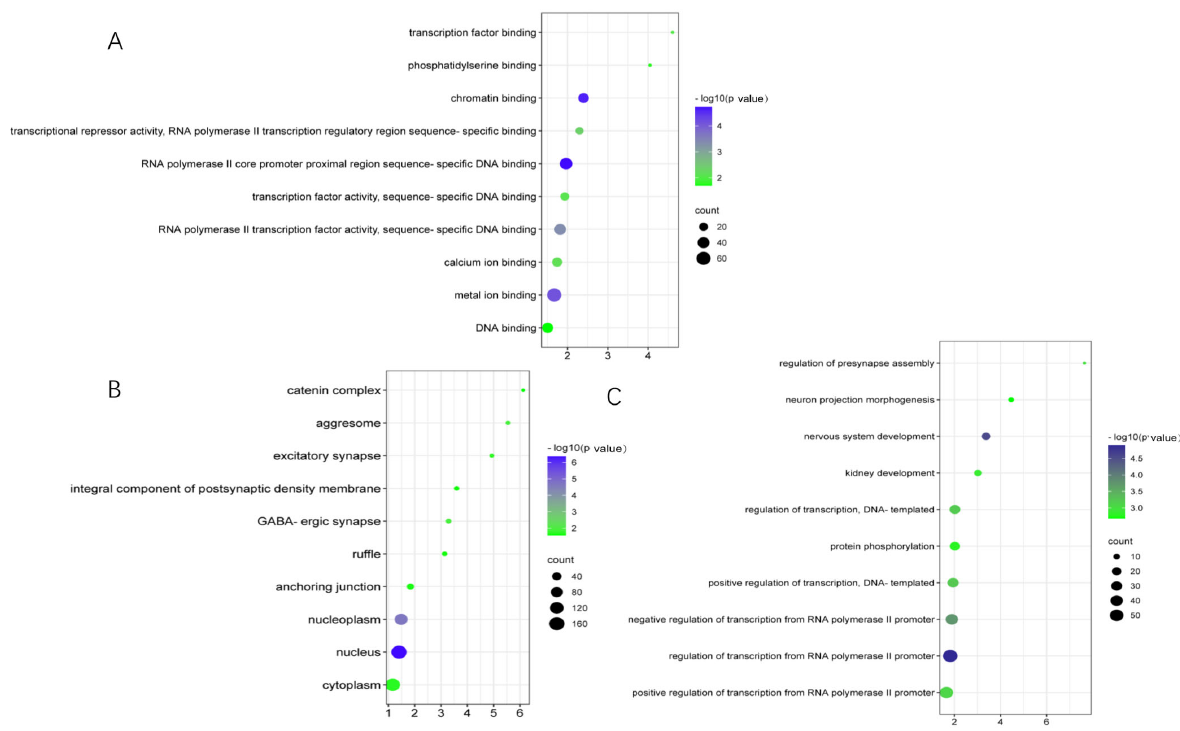
Figure 6. GO functional annotation of 188 overlapped genes of differentially m6A-modified mRNA and differentially expressed mRNA. ( A ) GO molecular function. ( B ) GO cellular component. ( C ) GO biological process.